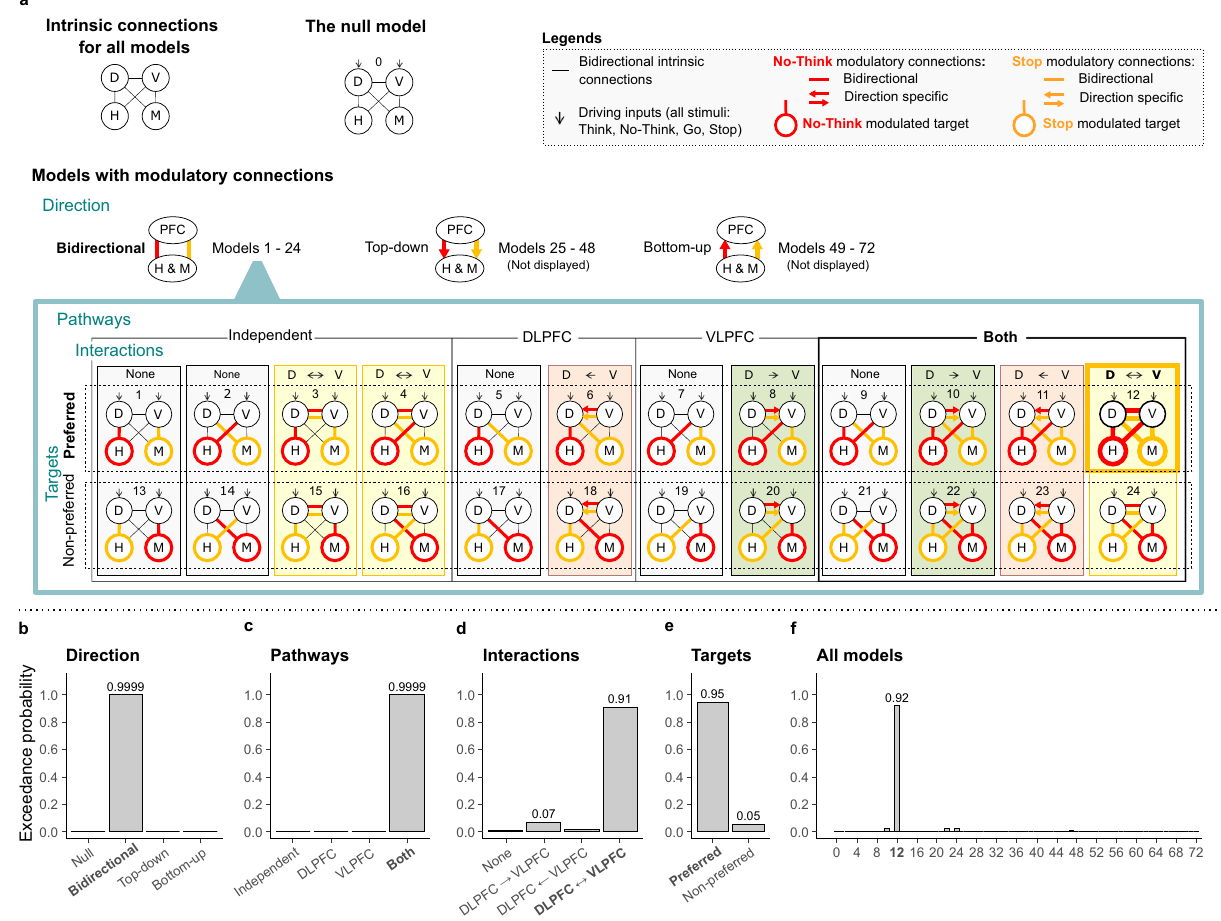
Fig. 7 DCM model space and results. a DCM analysis determined the most likely inhibition-related interactions between domain-general inhibitory control source areas (D: rDLPFC, V: rVLPFC) and domain-speci fi c target areas (H: right hippocampus, M: left M1). We compared 73 alternative models grouped into four family types. Direction: three families according to whether the source-target modulation is bidirectional, top-down, or bottom-up (we display only the 24 models within the bidirectional family as the further grouping was identical within each of the three families). Pathways: four families differing according to how Stop and No-Think modulate the pathways: independent modulation of target regions by rDLPFC and rVLPFC; rDLPFC only modulation; rVLPFC only modulation; or modulation by both rDLPFC and rVLPFC. Interactions: four families differing according to how Stop and No-Think modulate interactions between the rDLPFC and rVLPFC regions: no interactions; rVLPFC modulates rDLPFC; rDLPFC modulates rVLPFC; or bidirectional interaction between rDLPFC and rVLPFC. Targets: two families differing according to whether Stop and No-Think modulate the prefrontal connectivity with the preferred targets (M1 when stopping actions and hippocampus when stopping thoughts) or with the non-preferred targets (hippocampus when stopping actions and M1 when stopping thoughts). BMS (reporting exceedance probability to which a model is more likely to other models considered) overwhelmingly favoured models with b bidirectional source-target modulation; c both rDLPFC and rVLPFC modulating both the hippocampus and M1; d bidirectional interactions between the rDLPFC and rVLPFC; e the preferred target modulation. f The overall winning model also was strongly favoured by BMS even when directly assessing all 73 models, side by side, without grouping them into model families. b – f Source data are provided as a Source Data fi